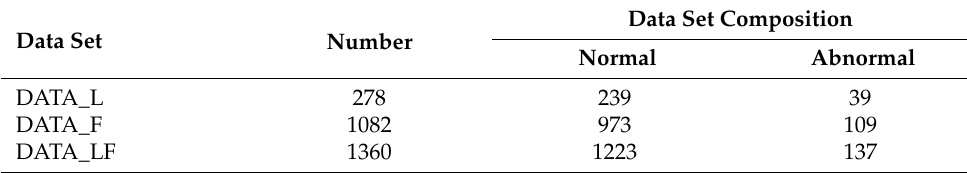
Table 14. Overview of experimental data sets.